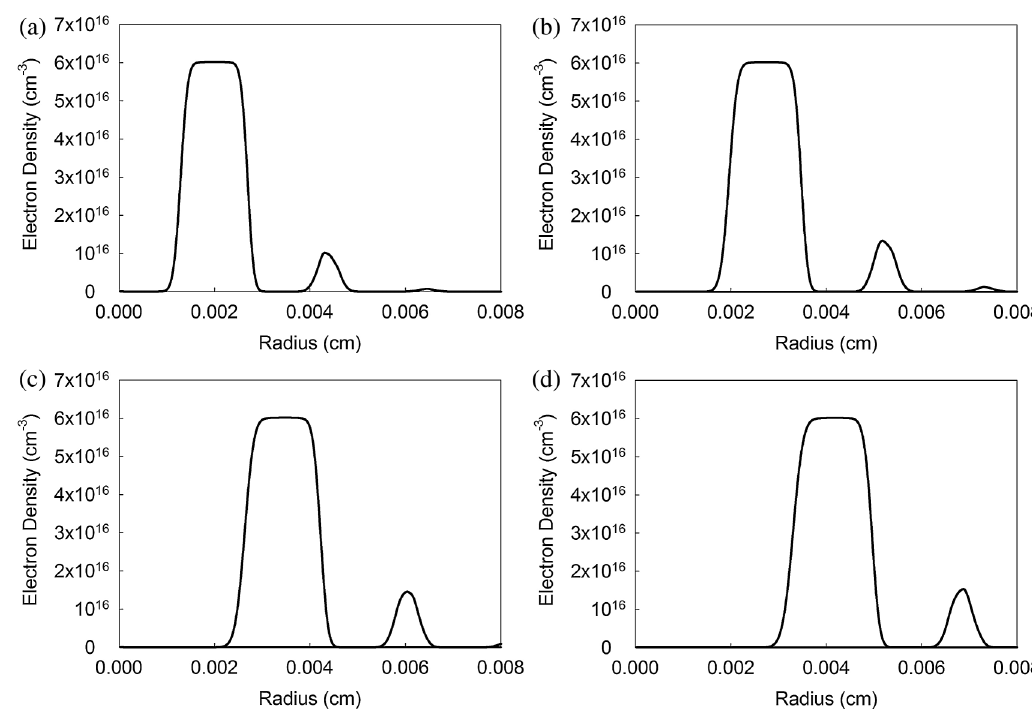
FIG. 6. Electron density results as a function of Bessel-beam order at 102 fs (laser pulse peak occurs at t ¼ 0 ). (a) J 2 beam. (b) J 3 beam. (c) J 4 beam. (d) J 5 beam.